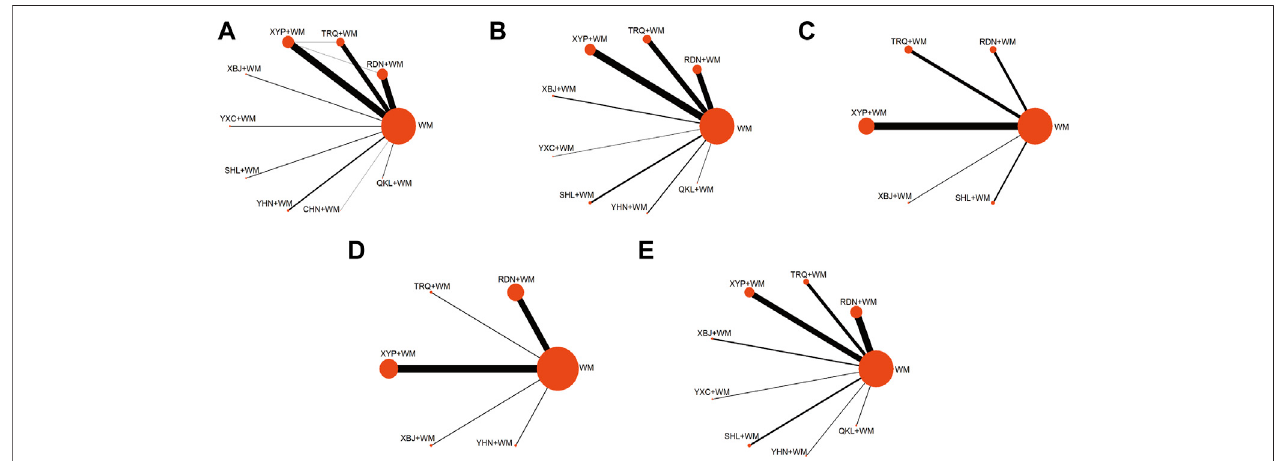
FIGURE 1 | Network graph of different interventions (A) Clinical effectiveness rate (B) Antipyretic time (C) Sore throat relief time (D) Red and swollen tonsils relief time (E) Tonsillar exudate relief time; WM, Western Medicine; RDN, Reduning injection; TRQ, Tanreqing injection; QKL, Qingkailing injection; XBJ, Xuebijing injection; SHL, Shuanghuanglian injection; YHN, Yanhuning injection; CHN, Chuanhuning injection; YXC, Yuxingcao injection; XYP, Xiyanping injection.